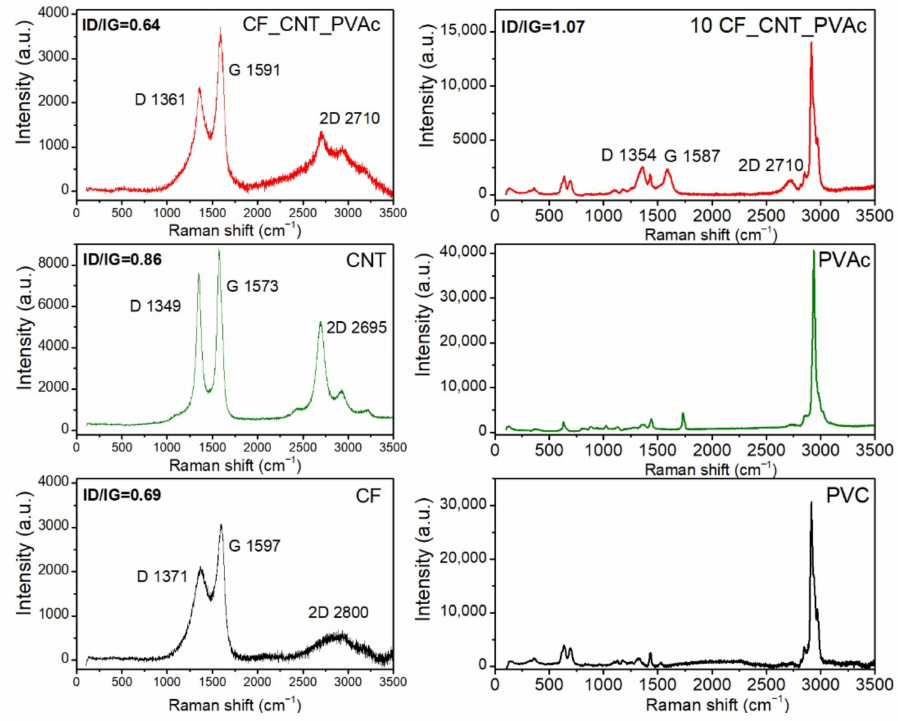
Figure 11. Raman Investigation of CF, CNT, hybrid filler, PVC, PVAc, and PVC composites modified by 10 wt% of hybrid